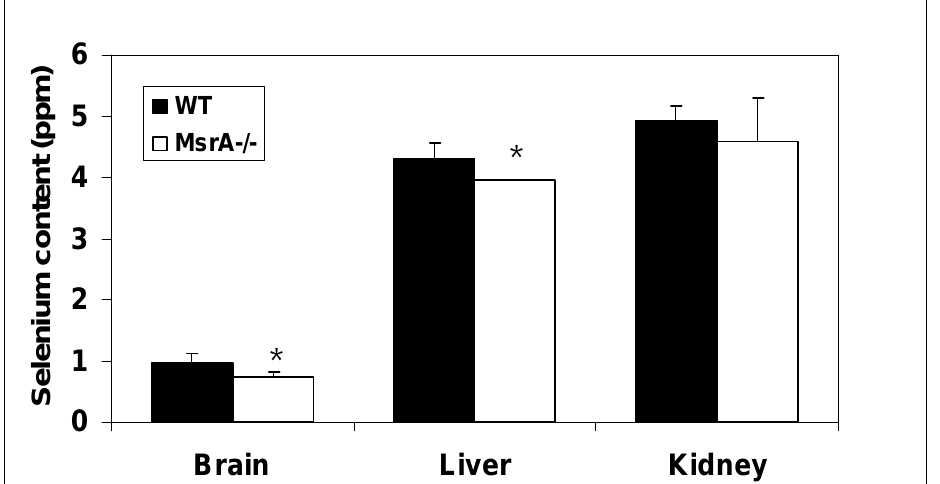
Figure 1. Selenium content in wild type and MsrA - / - mice. The selenium content (ppm) was measured by the relevant NAA method [20,21] in brain, liver and kidney using the same dry mass tissue from each organ. The quality control Sample was NIST SRM 1577 Bovine Liver (certified Se concentration = 1.1 +/- 0.1 ppm). The symbol * represents significant difference ( p =0.05; t-test ) between the averaged values of 3 independent experiments determining selenium content in tissues of wild type and MsrA - / - mice (significantly lower selenium levels were observed in brain (-23%; p =0.05) and liver (-8%; p =0.043) of MsrA - / - when compared with WT mice, respectively). Note: in the MsrA - / - liver all measurements gave the same value; thus, no standard deviation is